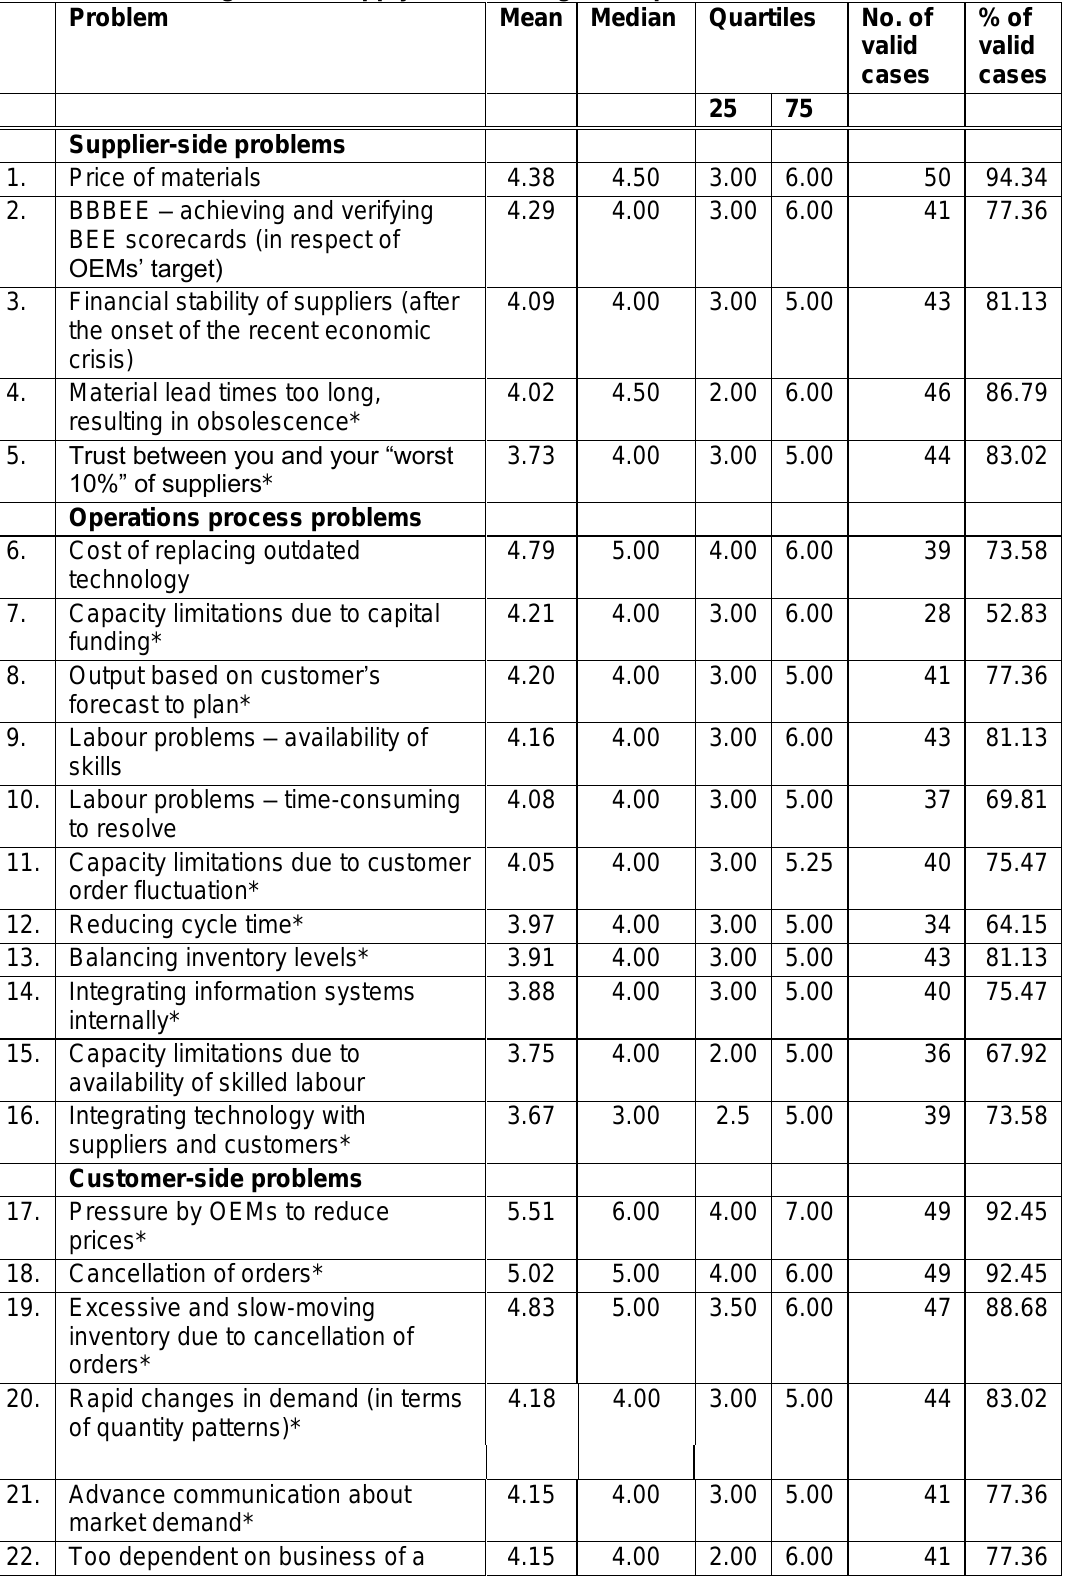
Table 1: Significant supply chain management problems